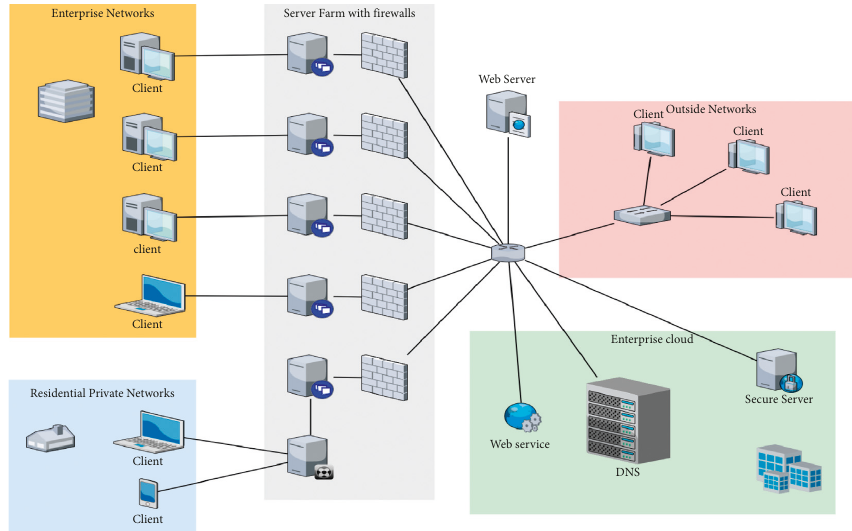
Figure 1: Internet communication